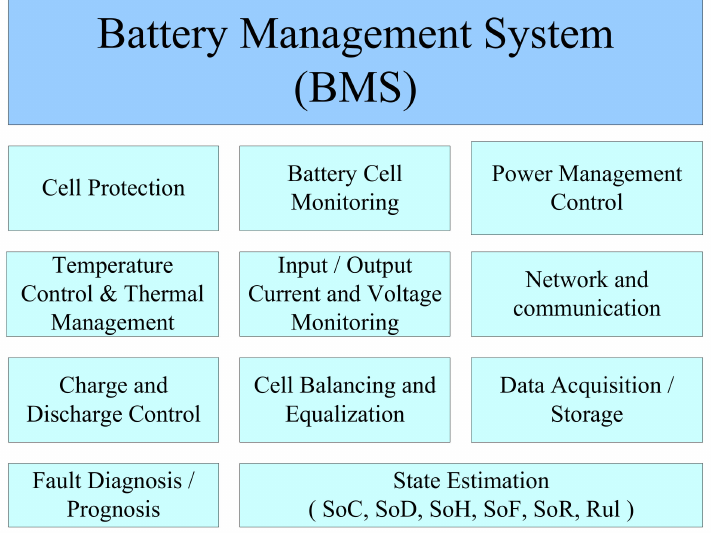
Figure 3. Applications of battery-management systems.